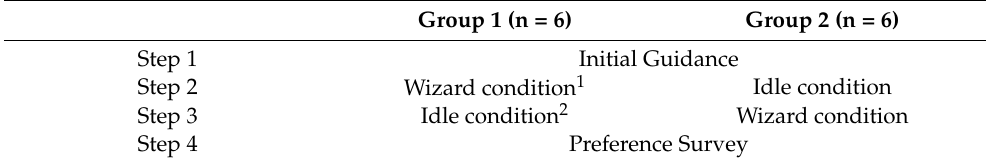
Table 2. Overview of the experimental